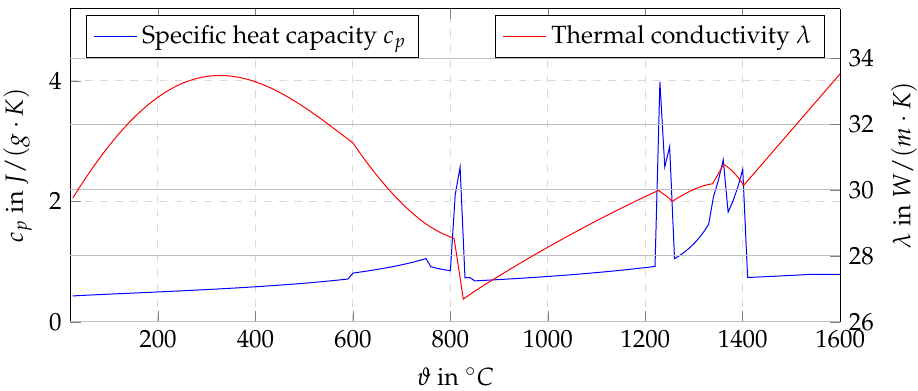
Figure 5. Calculated specific heat capacity and thermal conductivity of the filler material QuFe60 in dependence on